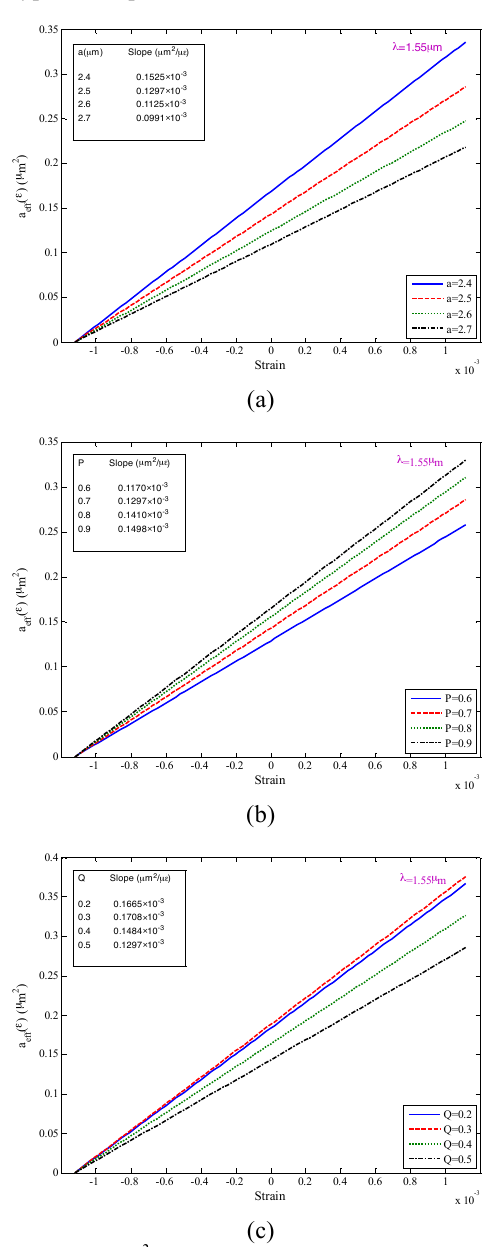
Figure 6: a ( µ m 2 ) vs. strain for (a) core radius (b) P (c) Q eff ,as